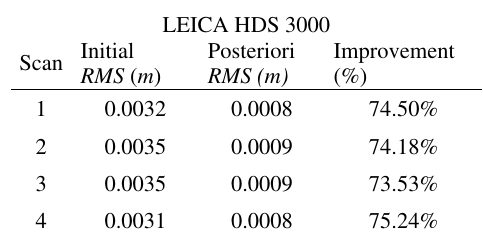
Table 3. RMS of residuals on the targets obtained in the registration of each scan station before calibration (Initial RMS making use of the original scanned point cloud for the external orientation, column 2) and RMS after calibration (after correcting the measurements with APs and re-calculating the external orientation, Adjustment 5, column 3).